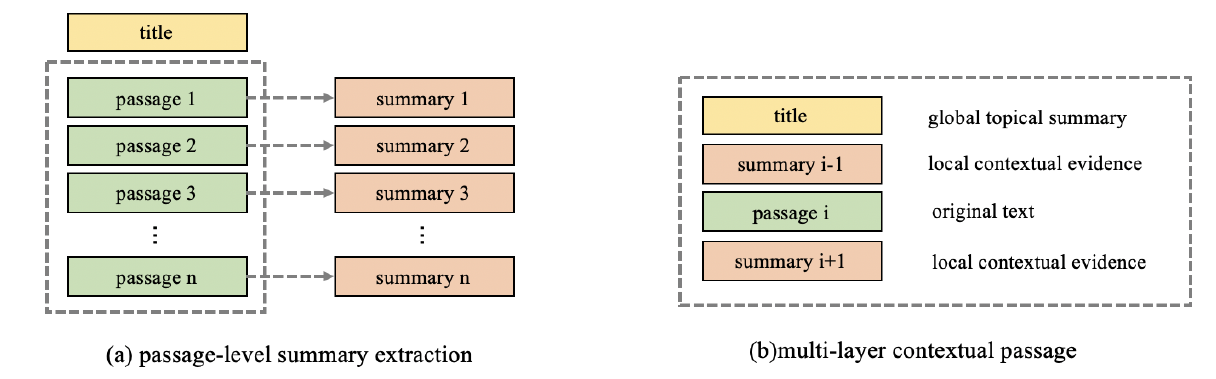
Figure 6. Generation of multi-layer contextual passage.